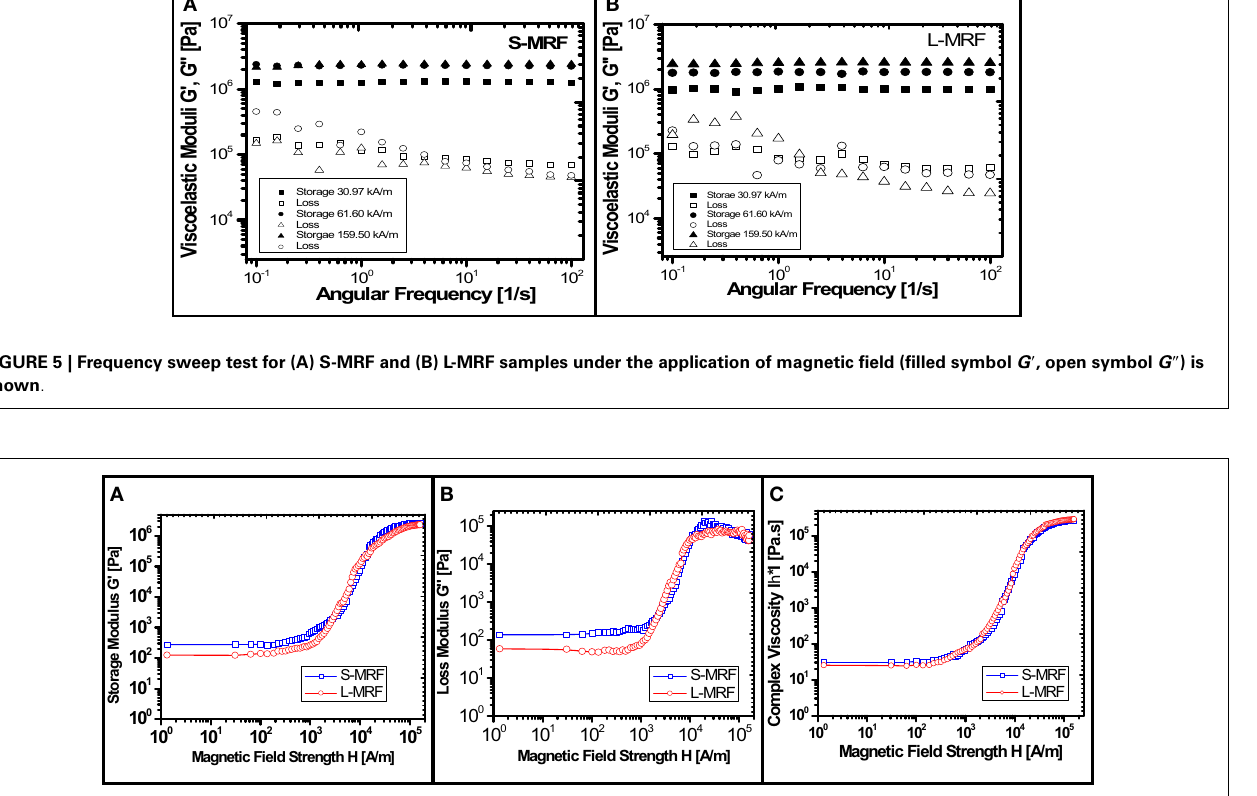
FIGURE 6 | Magnetic field dependence of (A) storage modulus G (cid:48) , (B) loss modulus G (cid:48)(cid:48) , and (C) complex viscosity for S-MRF and L-MRF samples is shown